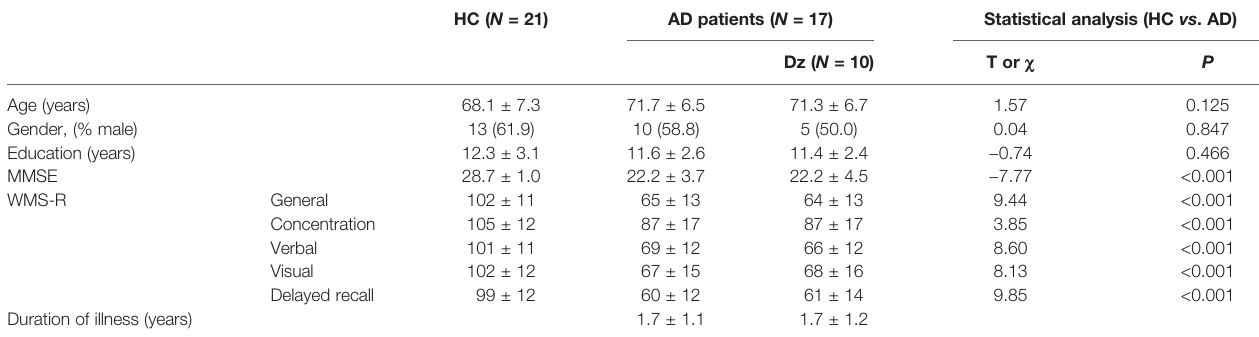
TABLE 1 | Data of the healthy controls (HC) and Alzheimer ’ s disease (AD) participants. HC ( N = 21) AD patients ( N =